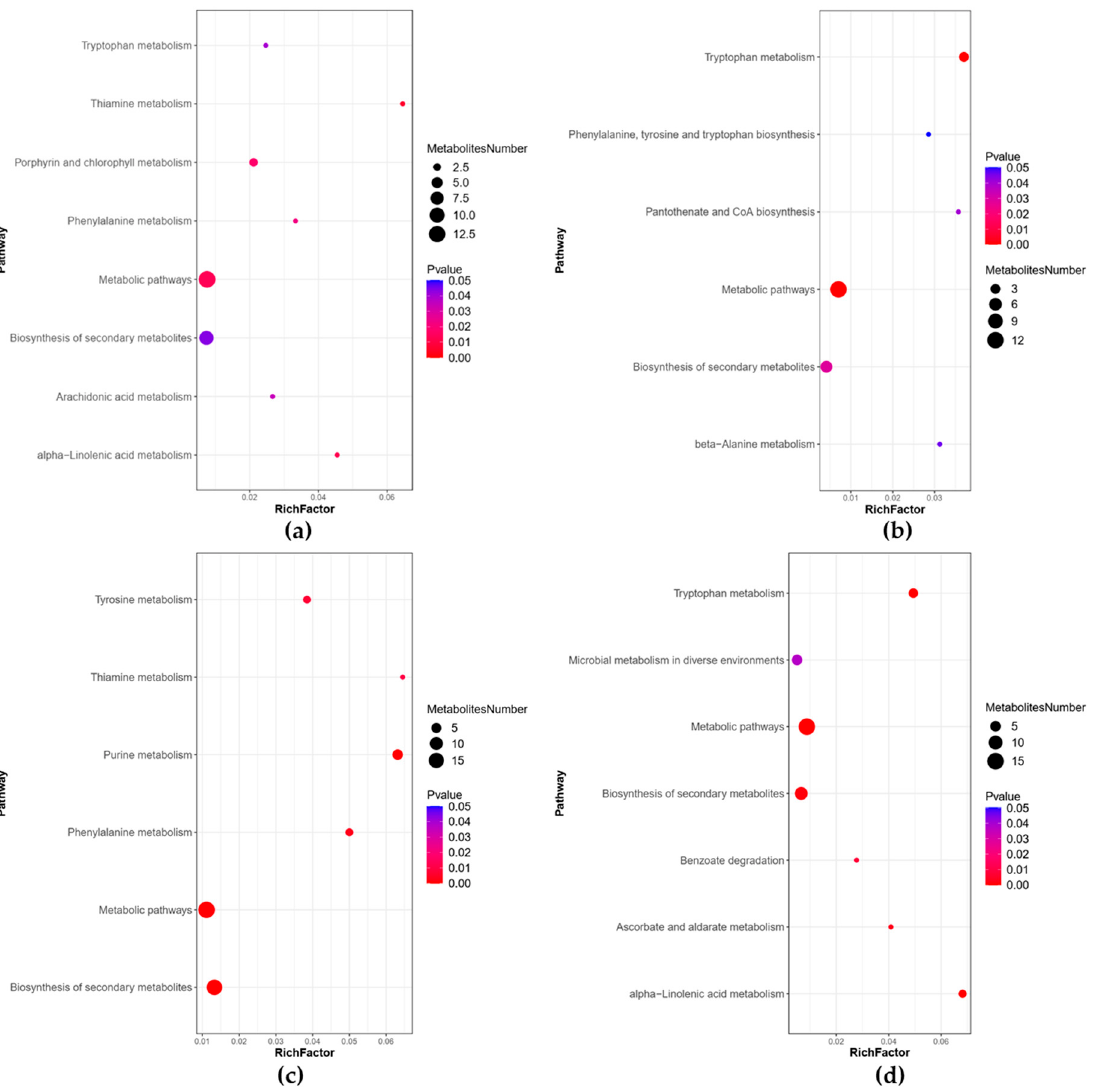
Figure 10. Bubble plots for metabolic pathway enrichment analysis. ( a ) Positive ion mode (WOPs-HG group vs. model group); ( b ) negative ion mode (WOPs-HG group vs. model group); ( c ) positive ion mode (WOPs-HG group vs. omeprazole group); ( d ) negative ion mode (WOPs-HG group vs. omeprazole group). X -axis enrichment factor (RichFactor) is the number of di ff erential metabolites annotated to the pathway divided by all identi fi ed metabolites annotated on the pathway. The larger the value, the greater the proportion of di ff erential metabolites. The dot size represents the number of di ff erential metabolites annotated to this pathway.